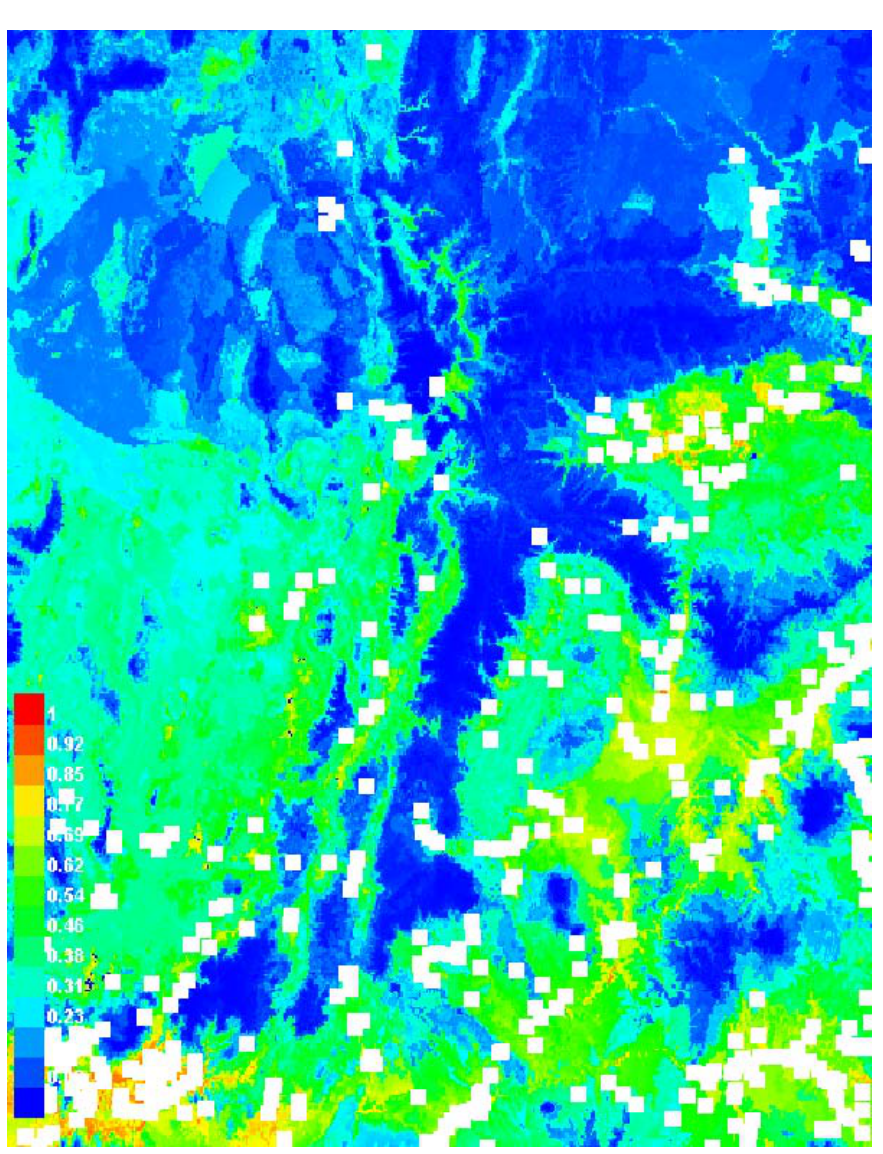
Figure 4. The model output for Tamarix within the state of